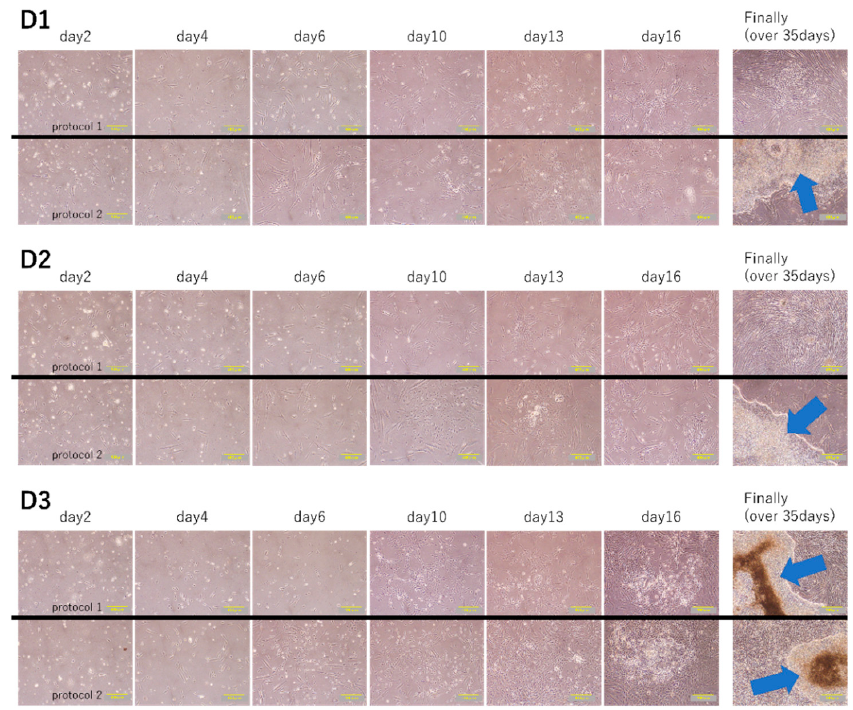
Figure 3. Induction of iPS cell colonies. The process of iPS cell induction in cells from three elderly patients. Gene transfection was performed on day 1. The time post-gene transfer is shown above each pair of images. Cells from D1 (top), D2 (middle), or D3 (bottom) were subjected to protocol 1 (upper row) or protocol 2 (lower row). Arrows indicate the iPS cell colonies that were eventually induced by day 35 post-transfection. Scale bars: 400 µm.